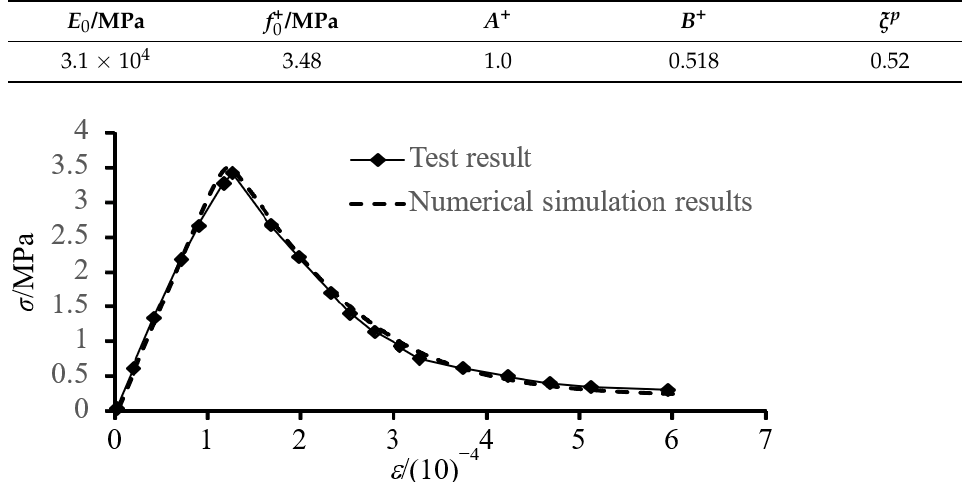
Table 1. Simulation parameters of the uniaxial tensile test.